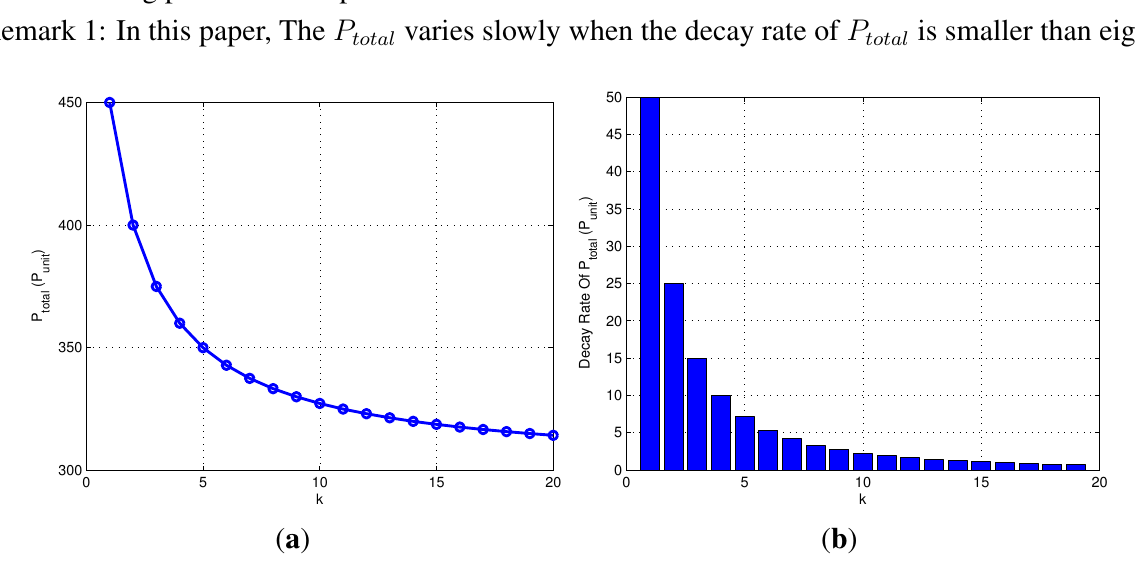
Figure 8. ( a ) Power consumption of the 100 communication cycles; ( b ) power decay rate of different values of k